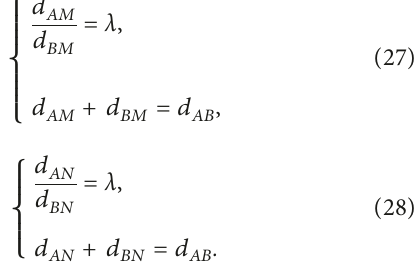
Figure 11: Schematic of distance ratio.